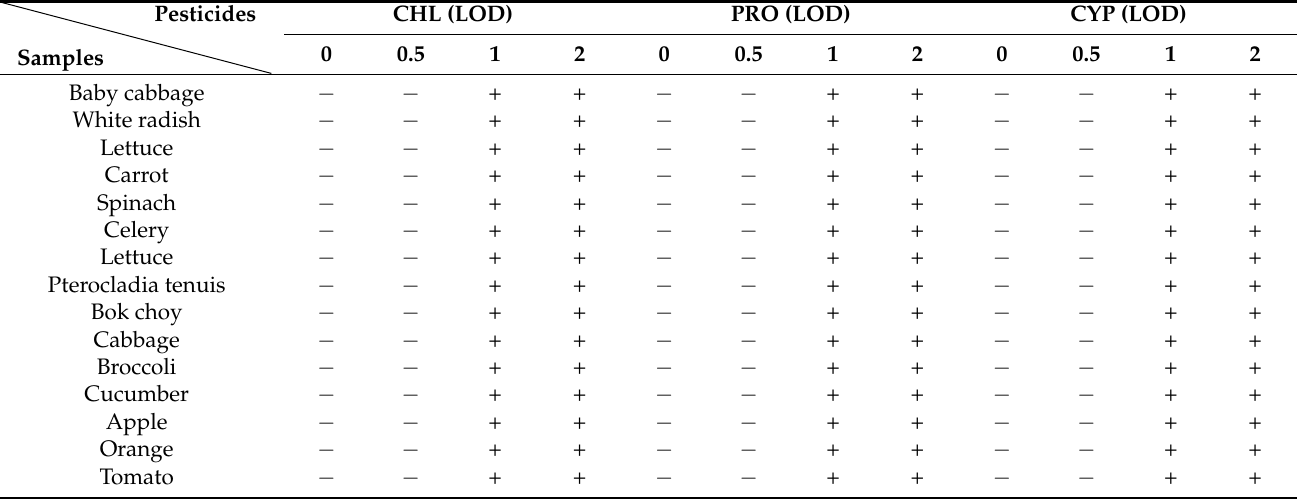
Table 4. Verification of the accuracy of pSBMA- µ PAD in the detection of CHL, PRO and CYP in 15 fruit and vegetable